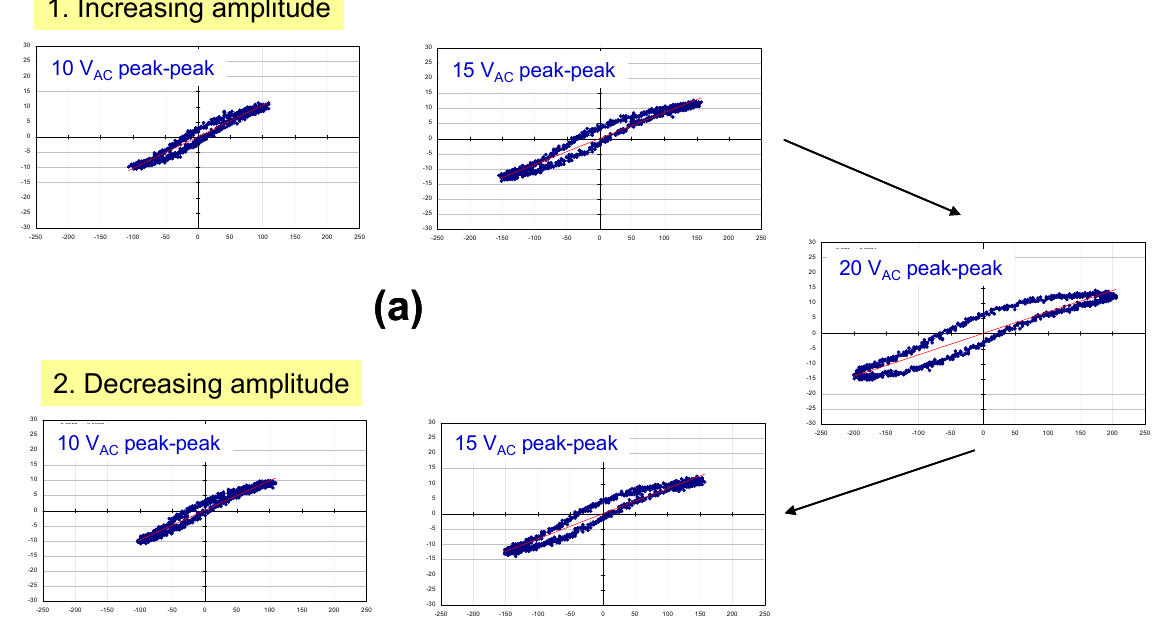
Figure 4. ( a ) Polarization vs . applied voltage hysteresis loops measured at 20 Hz for a capacitor with a Pt bottom electrode, a BCZTO dielectric deposited at 900 °C, 10 mtorr pressure, a sputter gas mixture of 10% oxygen/ 90% argon, and a Ni top electrode; ( b ) Blow up of hysteresis loop in (a) at 20 V